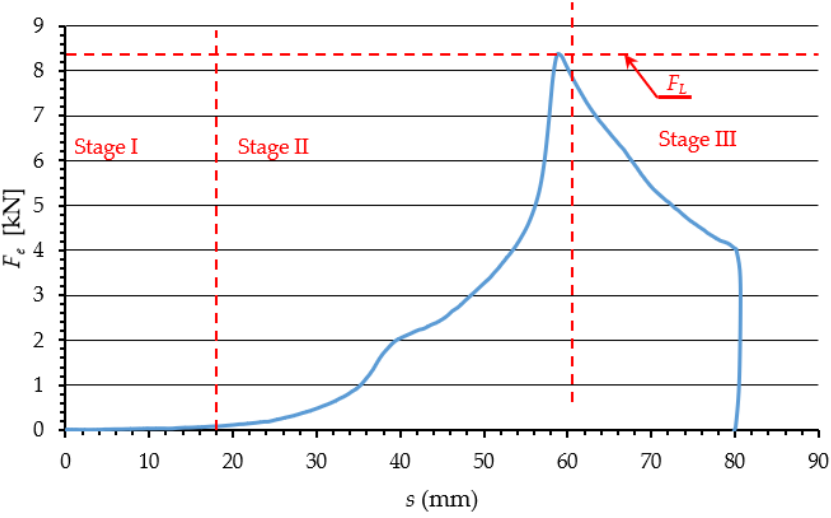
Figure 2. Phases of the compaction and extrusion process during one work cycle of the work system built for the purpose of this research: Phase 1—Initial compression, Phase 2—Final compression, Phase 3—Extrusion